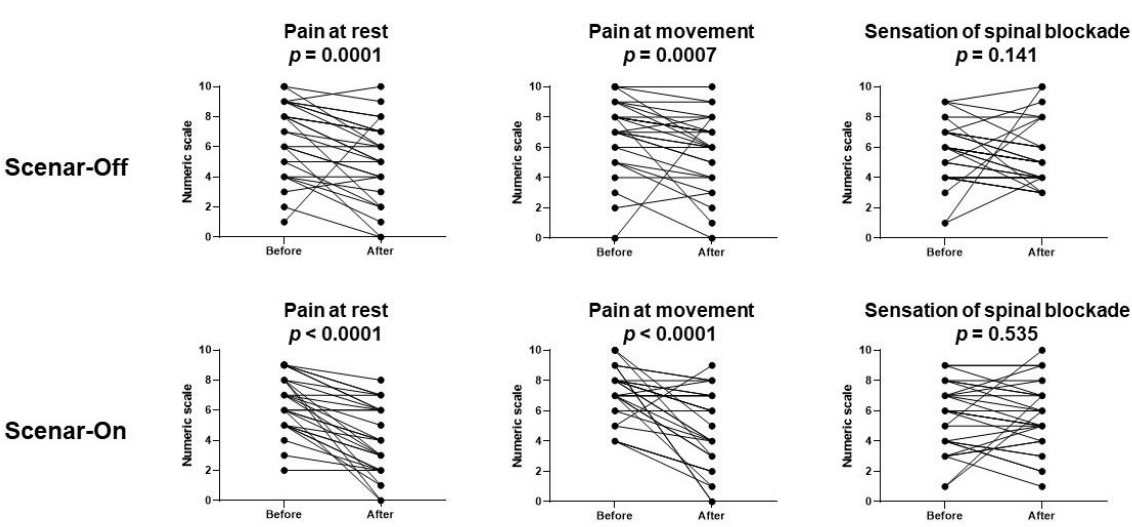
Figure 1. Evolution of pain scores and sensation of stiffness before and after the procedure. Scenar-Off: sham group with the Scenar TM device turned off; Scenar-On: treatment group with the Scenar TM device turned on. The data are presented as individual values.